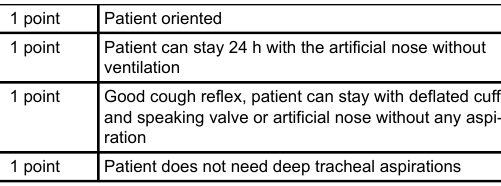
Table 2: Tracheo score index